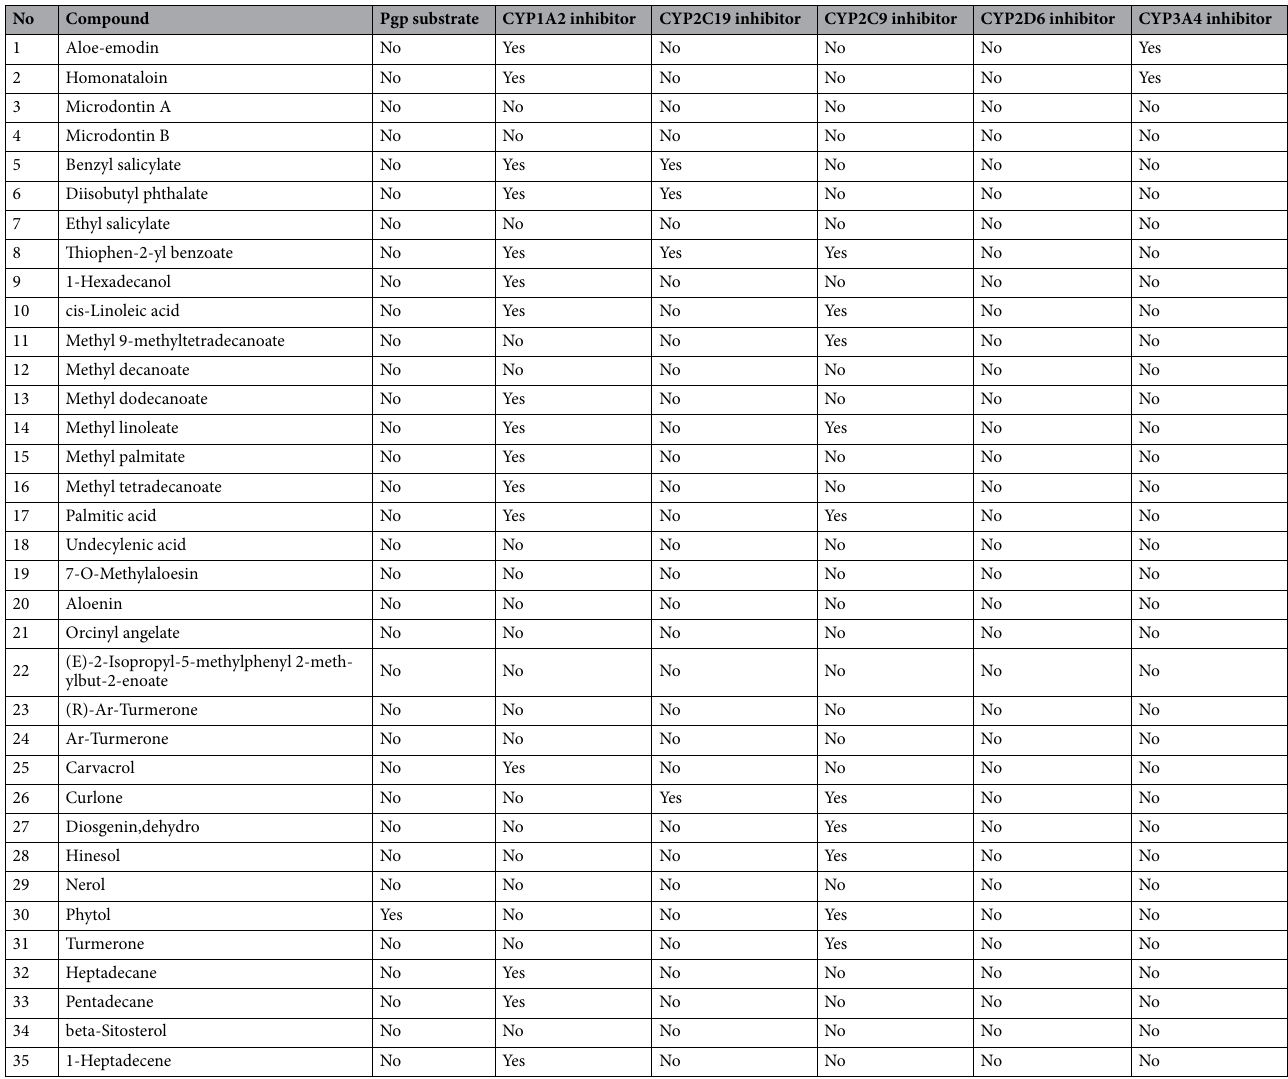
Table 3. Interaction of Ethiopian indigenous aloes’ phytochemicals with P-glycoprotein and cytochrome P450